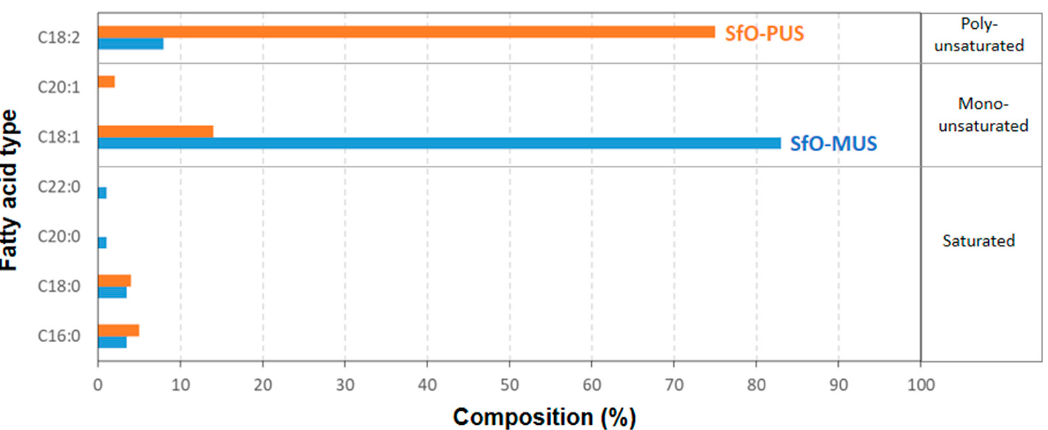
Figure 1. Fatty acid composition of sunflower oil (SfO) used for encapsulation in polymer nanoparticles, for SfO-PUS (poly-unsaturated) and SfO-MUS (mono-unsaturated).